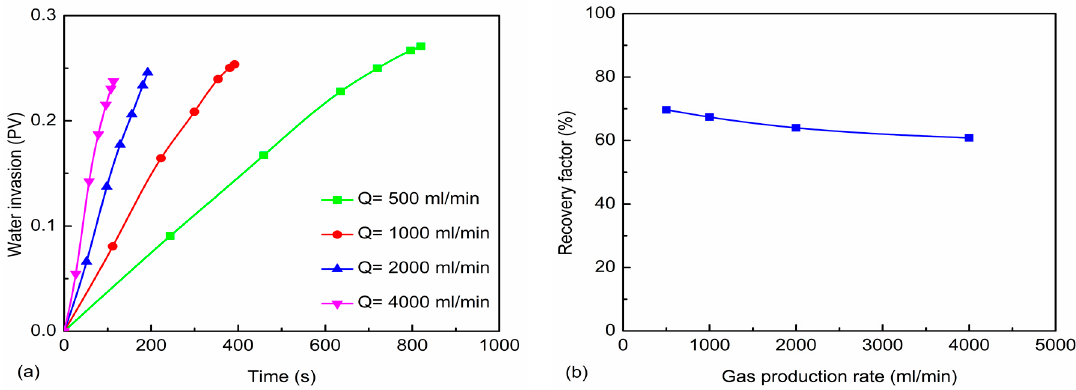
Figure 7. Water invasion versus time for different production rates and recovery factor versus gas production rate ( a ) Water invasion; ( b ) recovery factor.